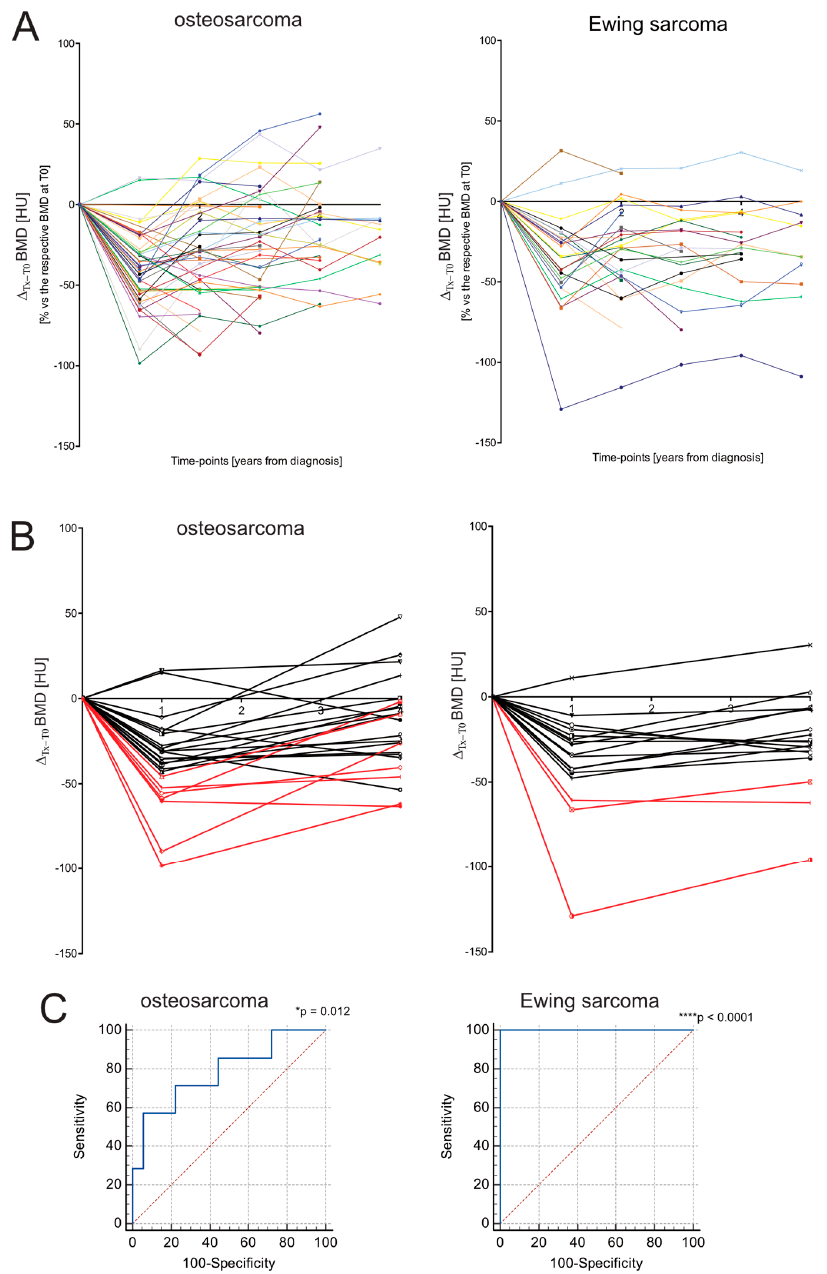
Figure 4. BMD trajectory at different follow-ups. ( A ) BMD was measured by ROI attenuation level of T 12 vertebrae as assessed by CT in OS ( n = 25), EW ( n = 15) at different follow-ups. The trajectory of BDM values over time is expressed as % of decrease in BMD value between T0 and the different time points (Tx) in respect the initial BMD value of the respective patient. We also intended to use the extent of Δ T1–T0 BMD as a predictor inversely related to the ability of patients to restore their bone